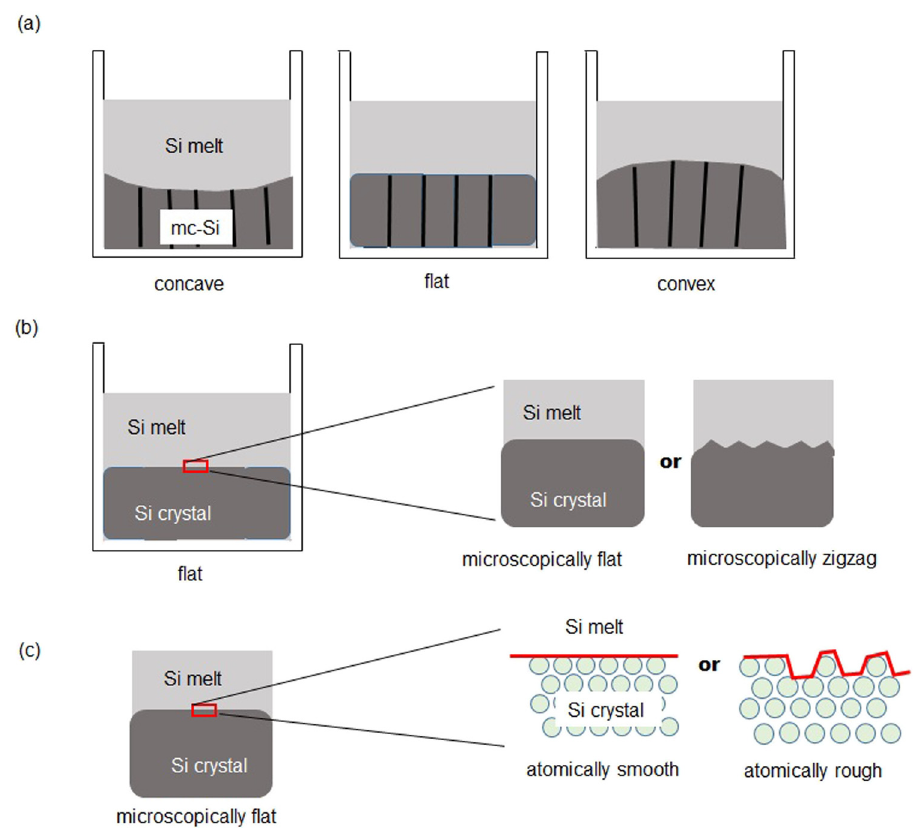
Figure 5: Schematic images of crystal/melt interface shapes on various scales: ( a ) macroscopic images of concave, fl at, and convex - shaped crystal/melt interfaces during directional solidi fi cation, ( b ) microscopic images of fl at and zigzag - shaped crystal/melt interfaces, and ( c ) atomic images of rough and smooth crystal/melt